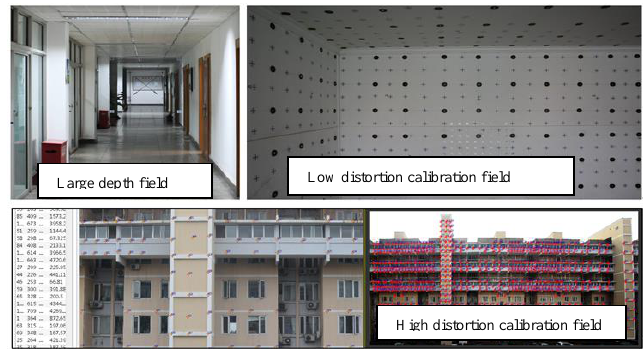
Figure 6. The camera calibration